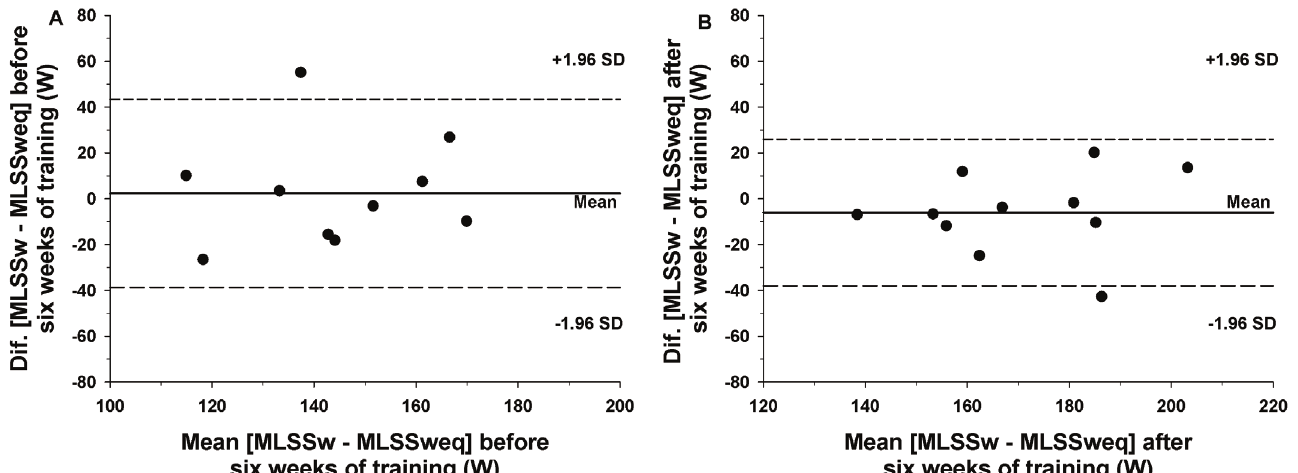
Figure 3. Limits of agreement between power output at maximal lactate steady (MLSSw) - power output at MLSS estimated by the regression equation (MLSSw ) of G2 before (A) and after (B) six weeks of aerobic eq